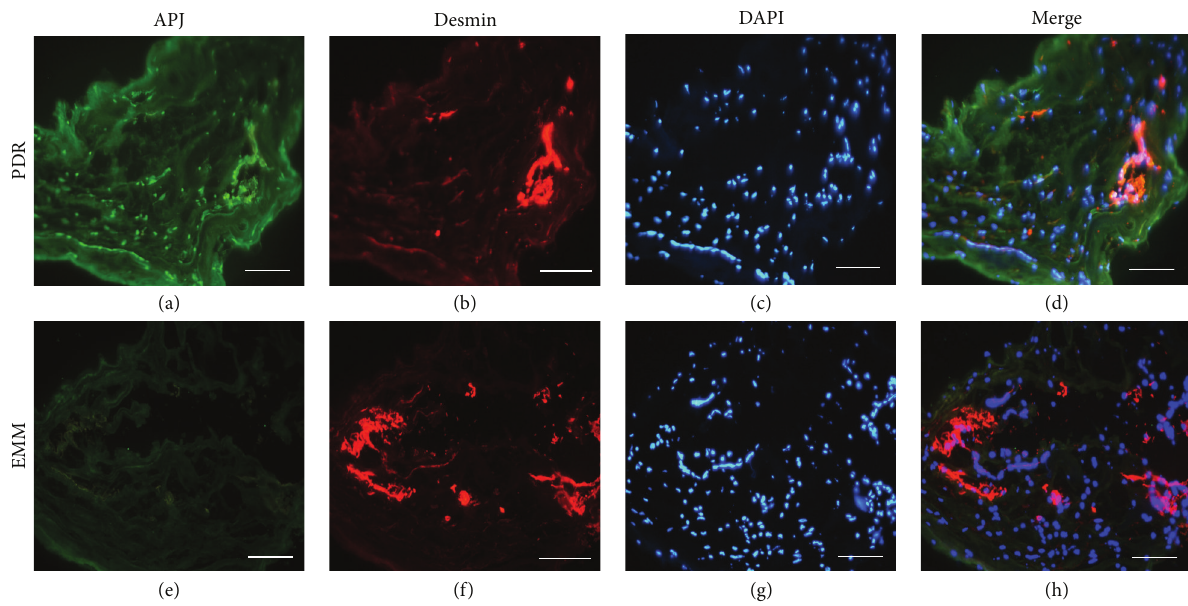
Figure 1: Immunostaining of APJ and pericyte in fibrovascular membranes. (a–d) Immunostaining for APJ (a), pericyte marker desmin (b), and DAPI (c) in fibrovascular membranes from eyes with proliferative diabetic retinopathy. Staining intensities of APJ were strong and were colocalized with pericyte, as identified by desmin. (e–h) Staining of APJ (e), desmin (f), and DAPI (g) in epiretinal macular membranes (EMM) of control patients without diabetic retinopathy. None of APJ (e) and staining of desmin (f) were observed. Scale bar = 100 𝜇 m.